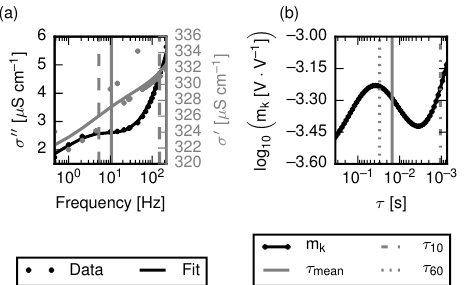
Figure 8. Debye decomposition (DD) of the recovered complex conductivity spectrum for a pixel from the stem area with maximum polarization response (see. Figs. 5 and 7): (a) complex conductivity (gray: real component; black: imaginary component) from spectral EIT (dots) and fitted DD response (solid curves); (b) corresponding relaxation time distribution. Vertical gray solid lines indicate τ mean , and the dashed vertical lines indicate τ 10 and τ 60 , respectively.